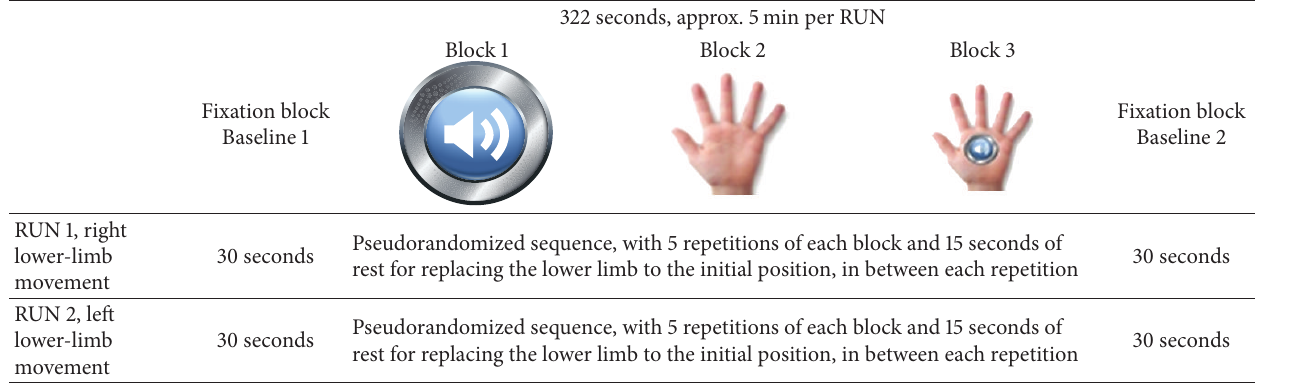
Table 2: Experimental